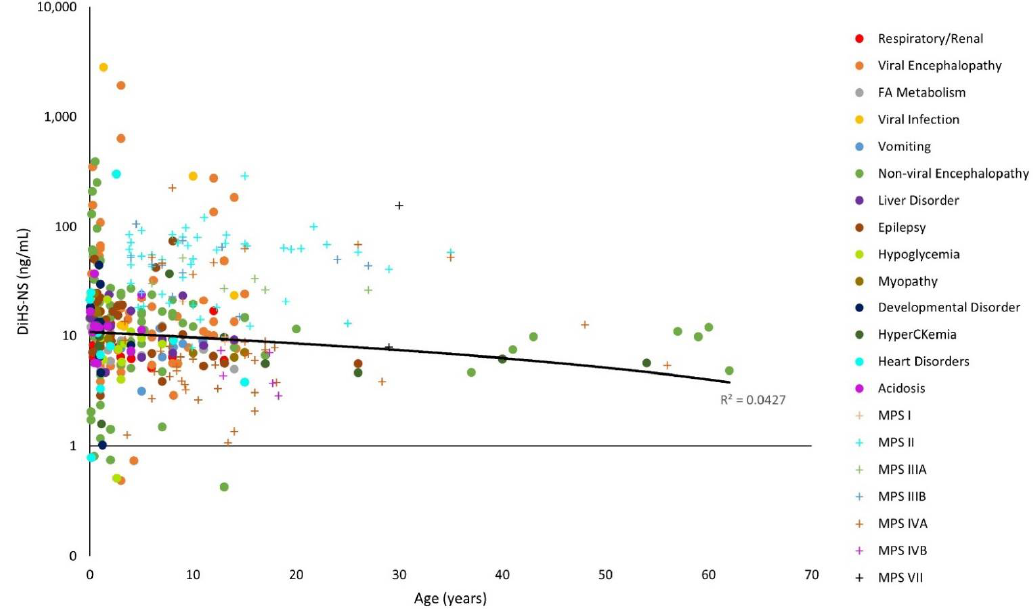
Figure 2. N -sulfated heparan sulfate (∆DiHS-NS) levels with age on a logarithmic scale. The linear trendline of control values is shown as a black line, and glycosaminoglycan (GAG) values of patients with mucopolysaccharidosis (MPS) are shown as plus marks.